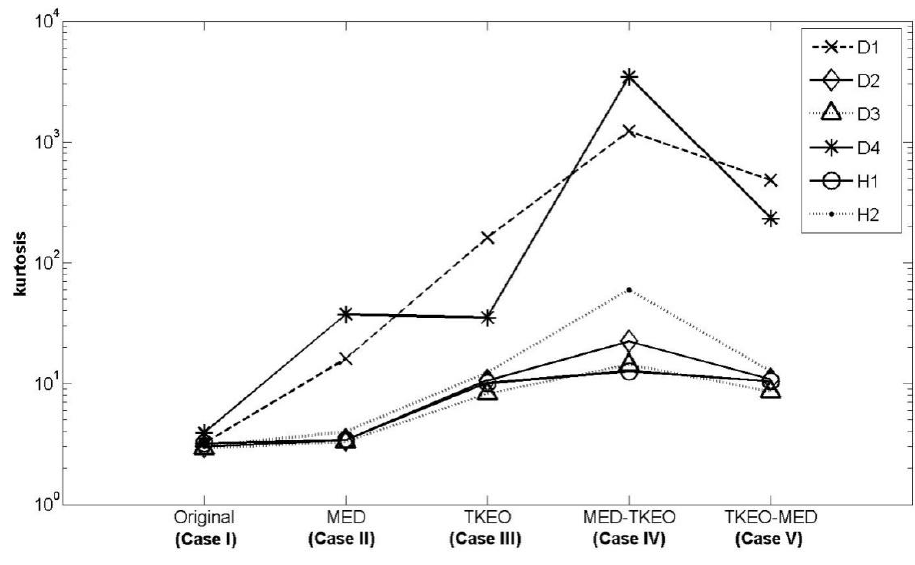
Figure 11. Comparison of kurtosis values after applying different signal processing cases (I–V) on two healthy (H1, H2), and four damaged (D1–D4) bearing data sets.